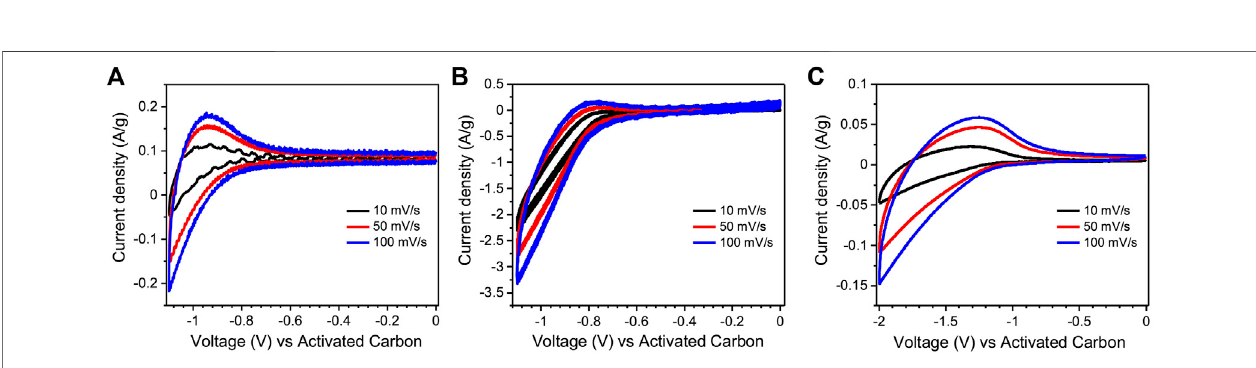
FIGURE 2 | Cyclic voltammetry in transistor con fi guration for route I TiO 2 fi lms gated with [EMIM][TFSI] (A) and 0.1 M NaCl (B) , and route II TiO 2 fi lms gated with [EMIM][TFSI] (C) . The scan rates are 10, 50, and 100 mV/s.